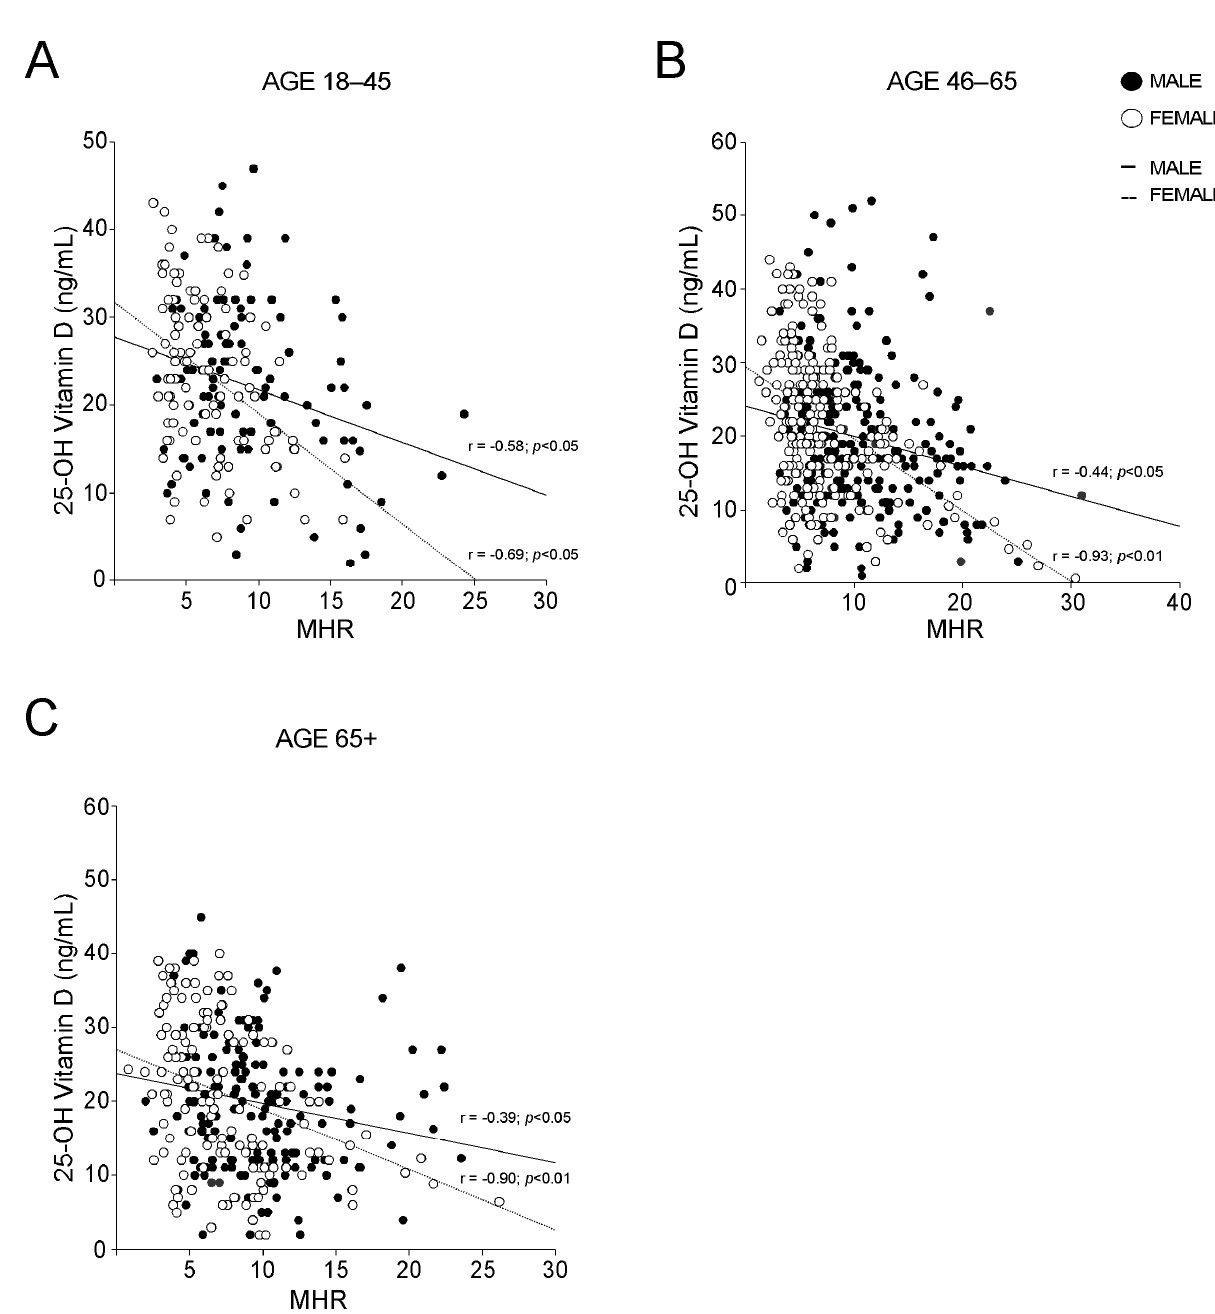
Figure 5. Gender-based correlation between 25-OH vitamin D and Monocyte-to-HDL ratio in different groups. ( A – C ) Correlation analysis of 25-OH vitamin D and MHR in male and female subjects; ( A ) analysis was conducted on subjects with age 18–45, ( B ) was conducted on subjects with age 46–65 and ( C ) was conducted on subjects with age 65+.